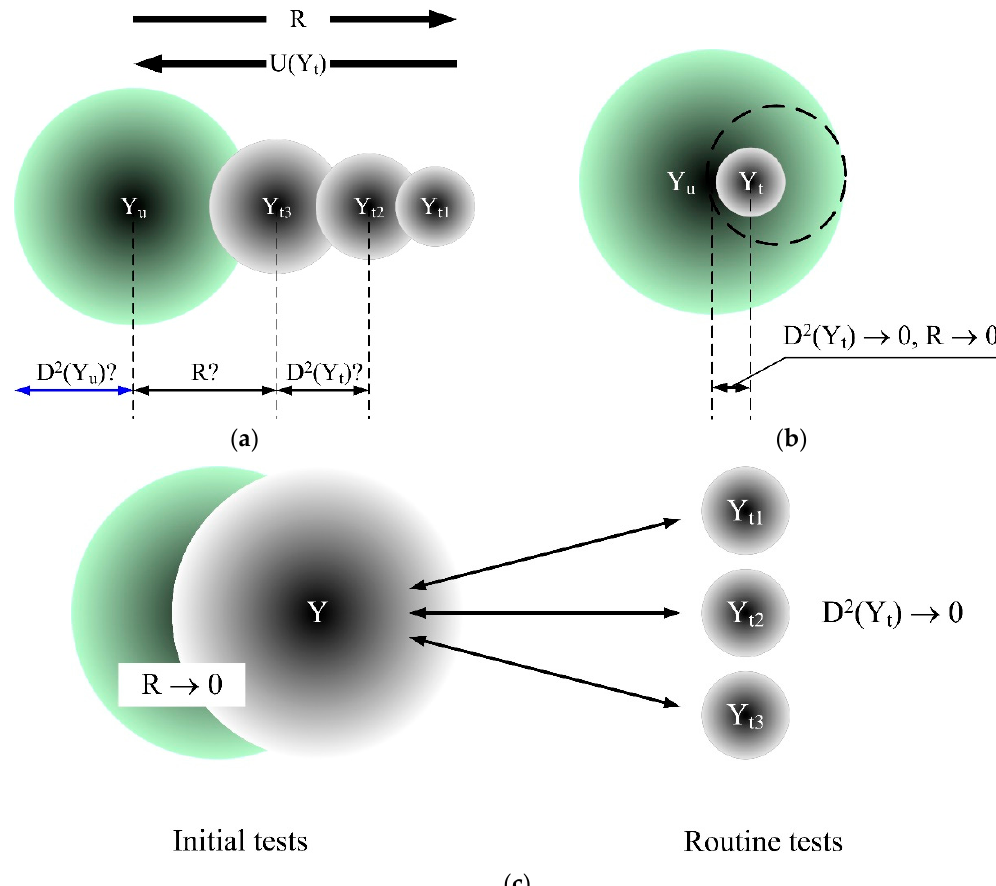
Figure 8. Illustration of the discrepancy between the material’s properties in actual conditions of use ( Y u ) and the test result ( Y t ), R = Y u − Y t . D 2 ( Y t ) —variability of test results. D 2 ( Y u )—symbolic variability of actual conditions. ( a ) Test results uncertainty reduction which results in a difference increase when related to actual conditions. ( b ) Simultaneous R and D 2 ( Y t ) minimization. ( c ) Tests modeling depending on the purpose.